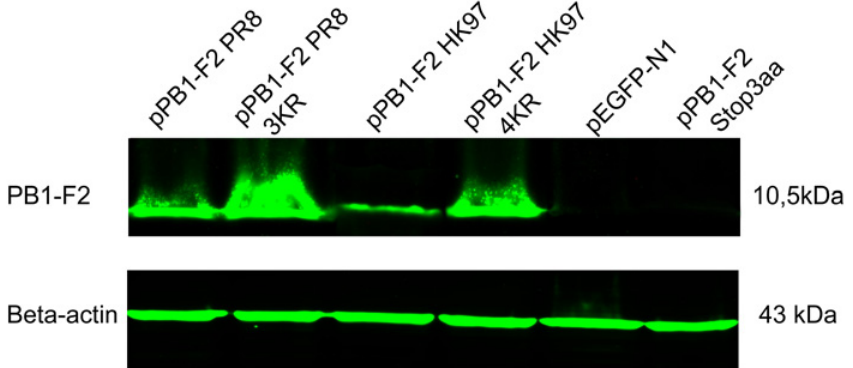
Fig 5. Comparison of the relative expression of the C-terminal cluster K ! R mutants of the PR8- and HK97-derived PB1-F2 compared with the wt. 293T cells were co-transfected with pEGFP-N1 (2 ng) and the respective PB1-F2-expressing plasmid (4 μ g pPB1-F2 PR8/pPB1-F2 PR8 3KR/pPB1-F2 HK97/ pPB1-F2 HK97 4KR/pPB1-F2 Stop3aa/pEGFP-N1 measured immediately before use). At 24 hr p.t., the transfection efficiency was estimated through epifluorescence. The cells were lysed and the protein concentration was measured. Equal amounts of proteins were loaded and separated through SDS-PAGE. The mAb AG55, specific for the N-terminal portion of PB1-F2, was used for the detection of PB1-F2, and the mAb C15 (Sigma- Aldrich) was used for the detection of Beta-actin. Alexa Fluor 790 Goat anti-mouse IgG (H+L) was used as secondary antibody. The nitrocellulose membrane was scanned using the Odyssey CLx infrared imaging system. Four independent experiments were performed and a representative result is presented.